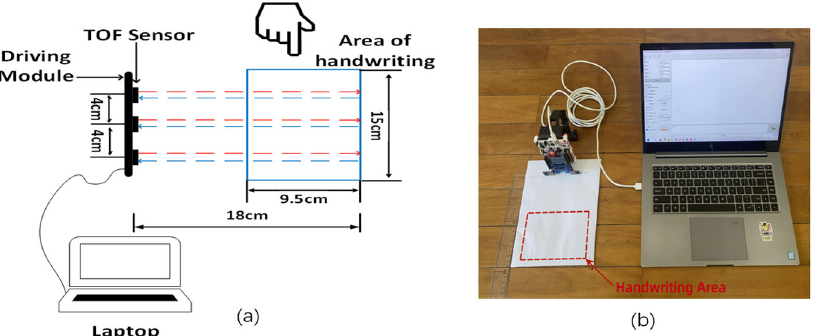
Figure 1. System overview. ( a ) Schematic of a distance ‐ measuring ToF sensors. ( b ) Experimental measuring device.